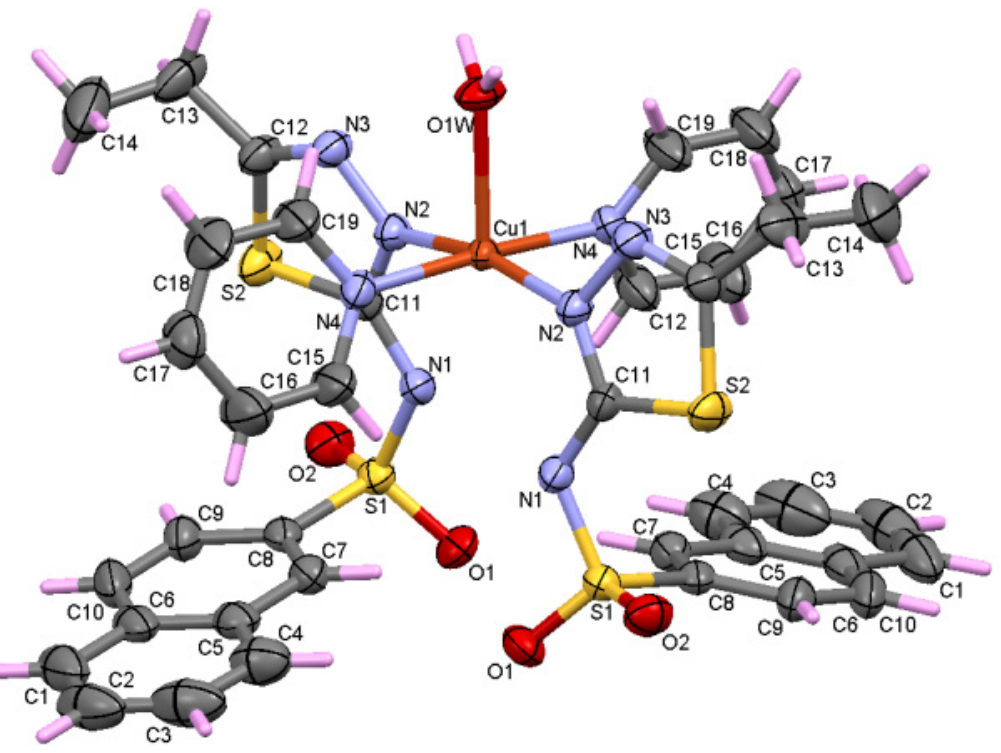
Figure 6. Molecular perspective of complex C2 displaying the atoms as thermal ellipsoids at the 50% probability level.